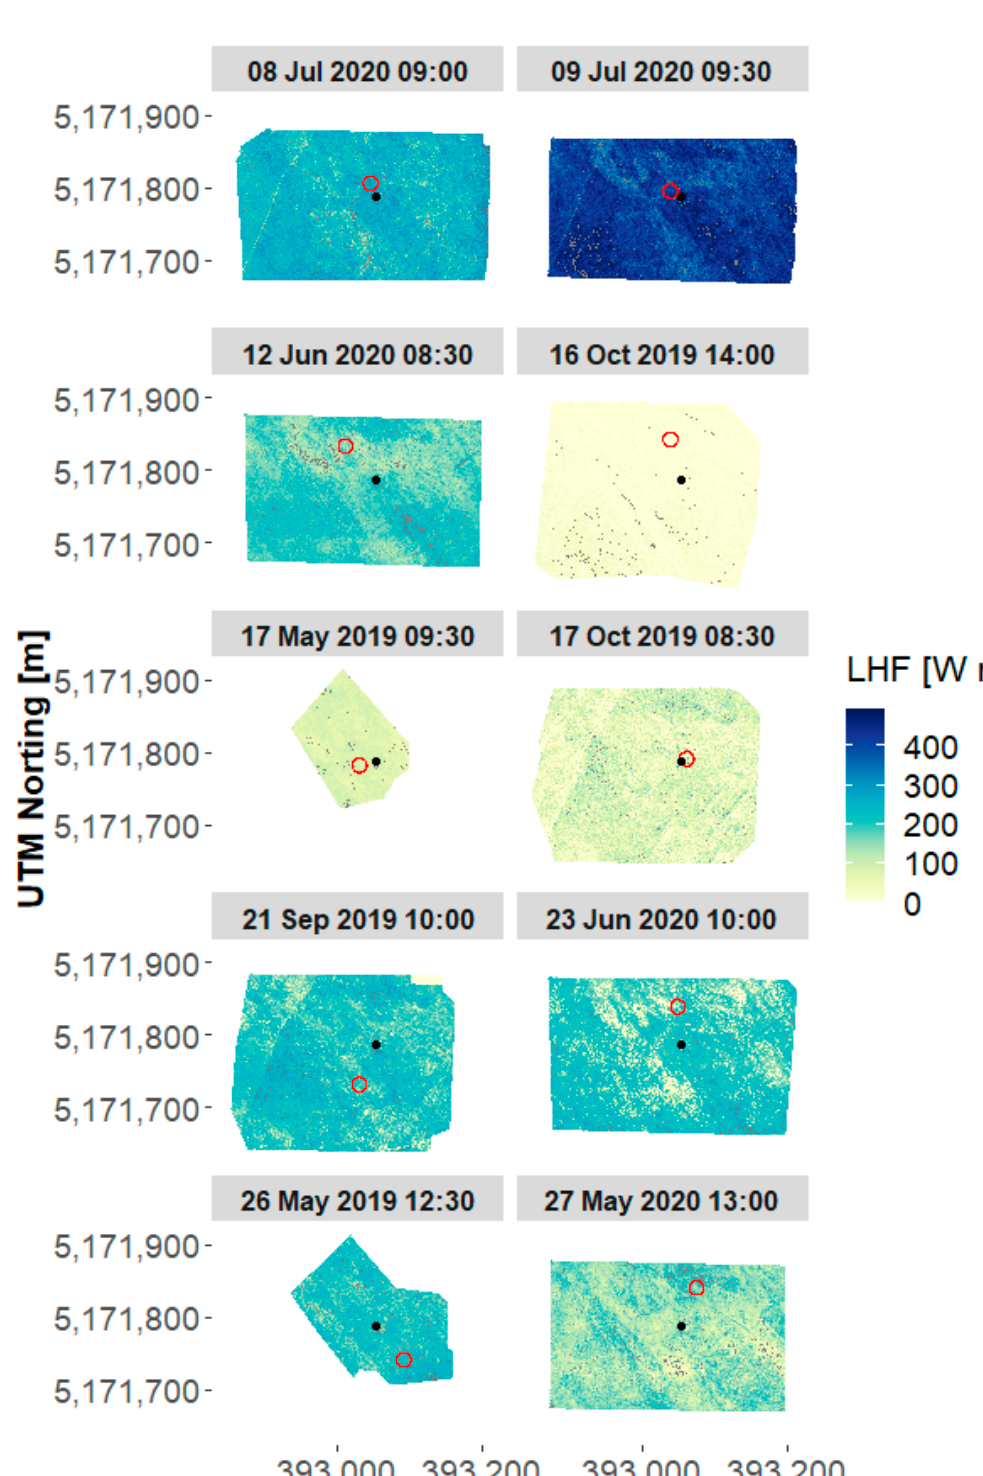
Figure A4. Latent heat flux maps of the grassland (Bugac) site in 2019 and 2020. The black dot indicates the position of the eddy-covariance tower, while he red circle indicates the footprint area from which the averages for validation were calculated.